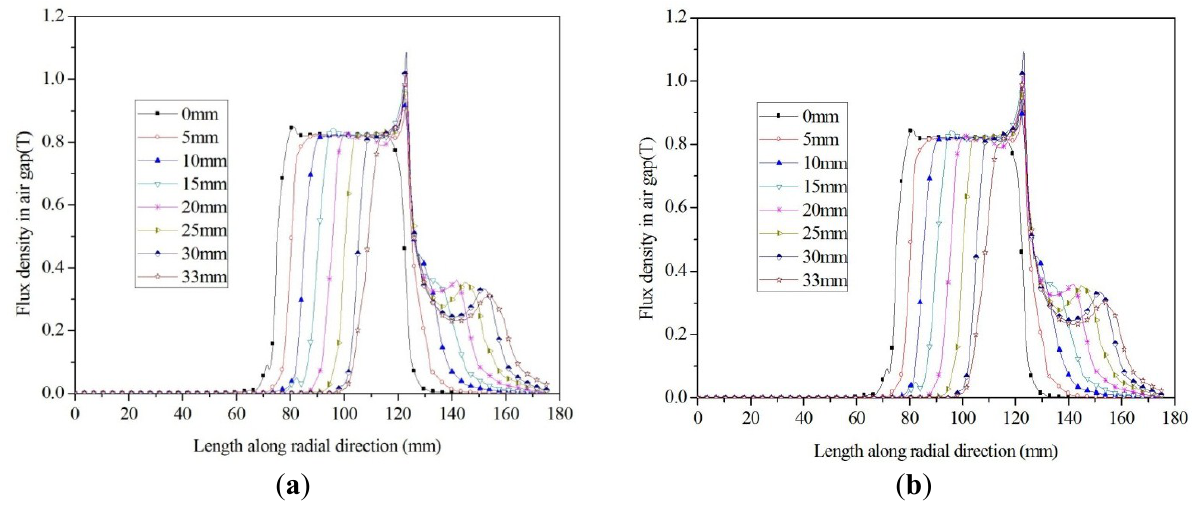
Figure 6. The magnetic flux density distributed in the air gap: ( a ) rolled lamination ( b ) soft magnetic composite